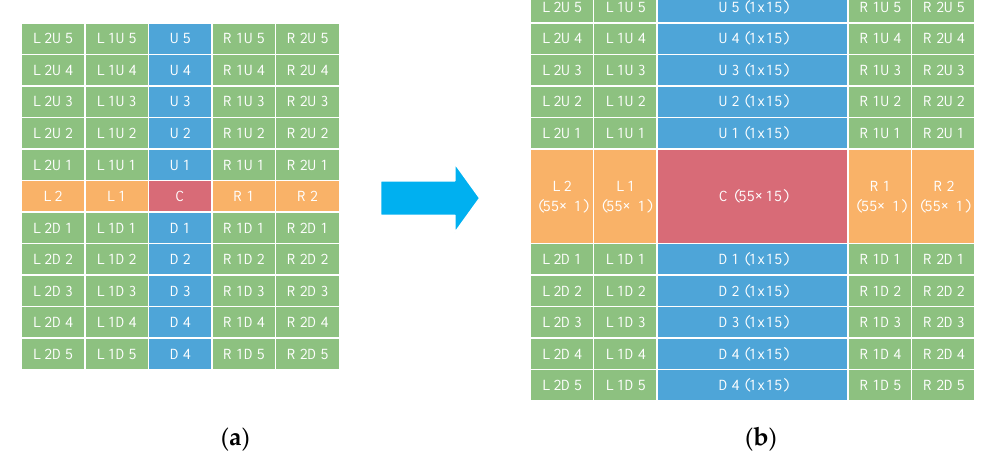
Figure 10. Schematic representation of the transformation from ( a ) small array with 11 × 5 sub-array elements to ( b ) a large array of 65 × 19 elements. In ( a ) each block represents a sub-array placed in the specific location. In ( b ) the various blocks represent sub-domains (with dimensions indicated into brackets) synthesized using the relevant embedded sub-array patterns in ( a ). The green blocks are 1 × 1 sub-arrays.